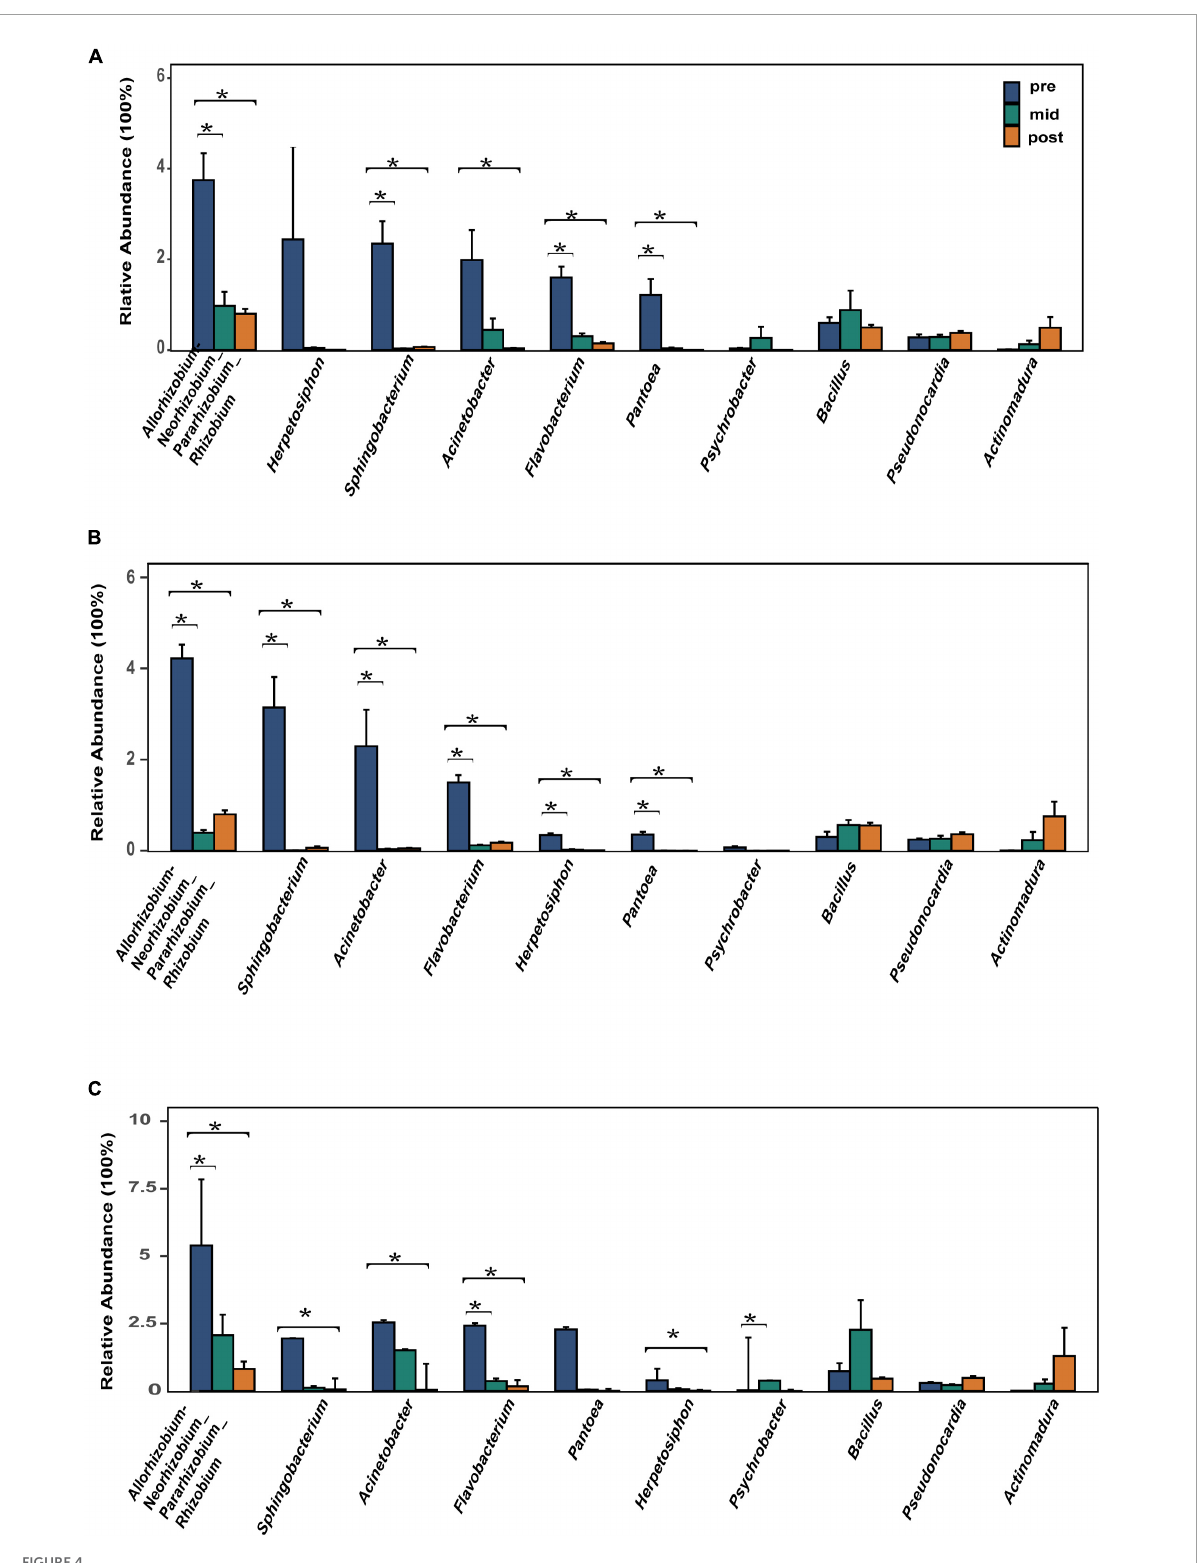
FIGURE4 Relative abundance of the 10 most abundant bacterial genera. (A) Bamboo leaf groups. (B) Couch grass groups. (C) Mixed litter groups. Significant results ( p < 0.05) from the differential abundance analysis between different incubation periods are shown as asterisks (*). Pre, pre-incubation period; mid, mid-incubation period; post, post-incubation